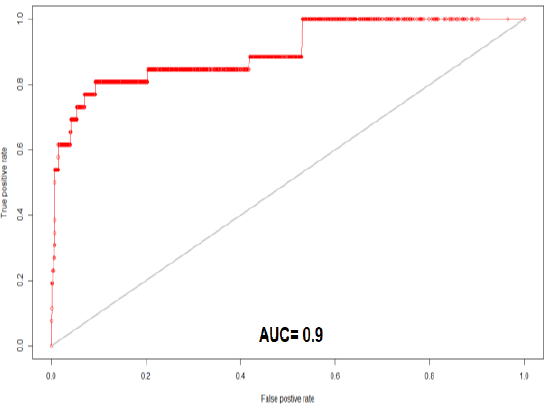
Figure 6. AUC plot against test data of second